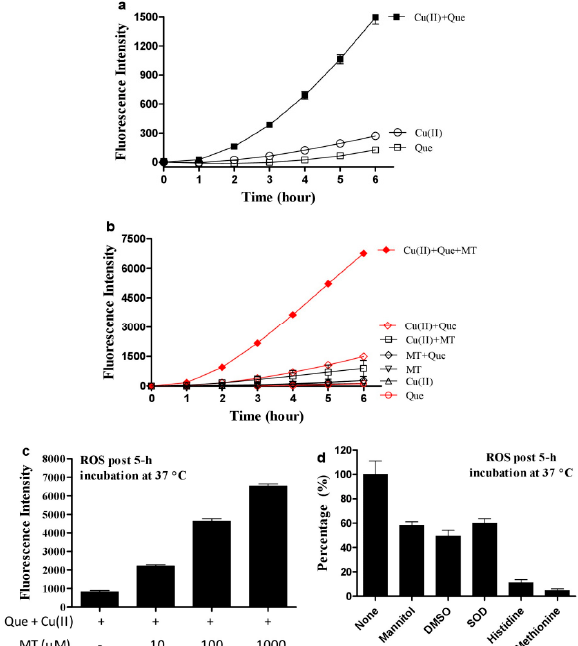
Figure 1. Melatonin enhances ROS production from quercetin and copper. ( a ) ROS production by Cu(II) (1 µ M) plus Que (10 µ M). ( b ) Melatonin (MT, 100 µ M) markedly enhanced ROS formation by Cu(II) (1 μ M) plus quercetin (Que, 10 μ M). ( c ) Dose-dependent effect of melatonin on ROS production in the redox system of Cu(II) (1 μ M) and Que (10 μ M). ( d ) Inhibition of ROS formation in the system of 1 µ M Cu(II) / 10 µ M Que / 100 µ M MT by Mannitol, 100 mM; DMSO, 5%; SOD, 10 U / mL; Histidine,